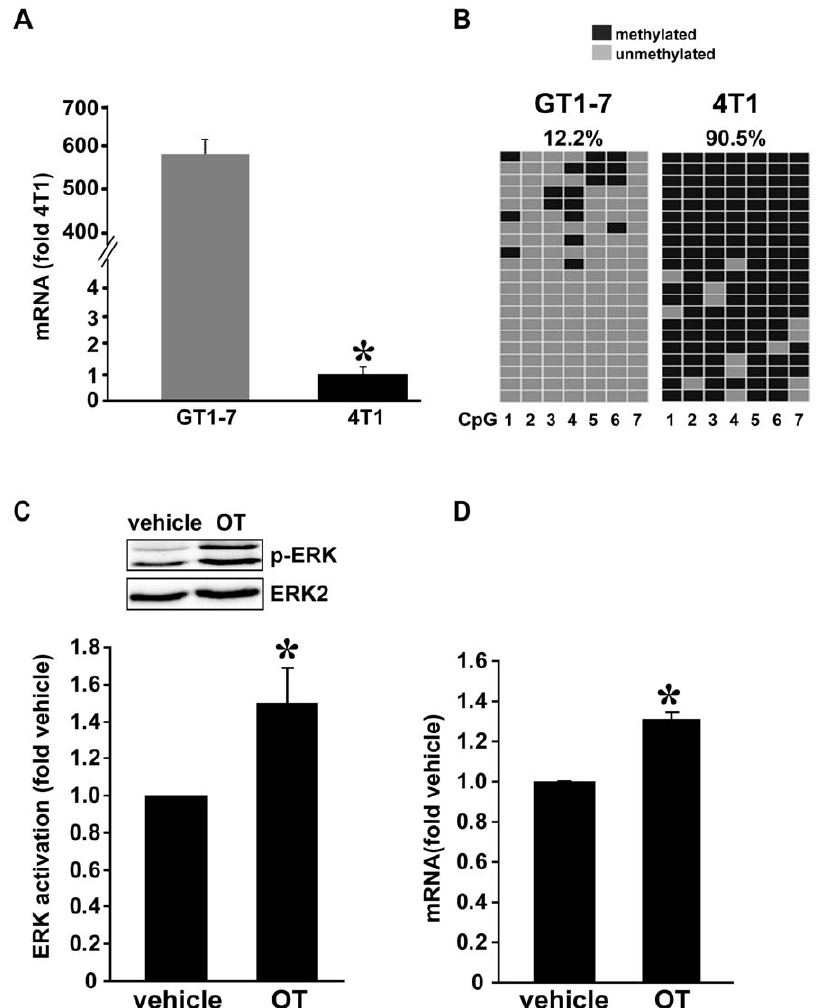
Figure 2. Oxtr mRNA levels correlate with Oxtr promoter methylation in cell lines. A ) The relative mRNA levels in GT1-7 are significantly higher than in 4T1 cells. B ) Methylation of the seven CpG sites is higher in 4T1 cells than in GT1-7 cells. Each row represents a single clone and each column represents one of the seven CpG sites. The total percentage of methylation was calculated from the fraction of black spots (methylated CpG sites). C ) Representative gel showing greater ERK phosphorylation in GT1-7 cells stimulated with 1 m M OT for 10 min compared vehicle-treated cells Graph is summary of three independent experiments. D ) Quantities of Oxtr mRNA in GT1-7 cells following 24 h treatment with 1 m M OT. An OT- stimulated increase in Oxtr mRNA was documented in three independent experiments. Statistics (t-test): A ) * p , 0.001, n=4. C ) * p , 0.05, n=3. D ) * p , 0.01 n=3.